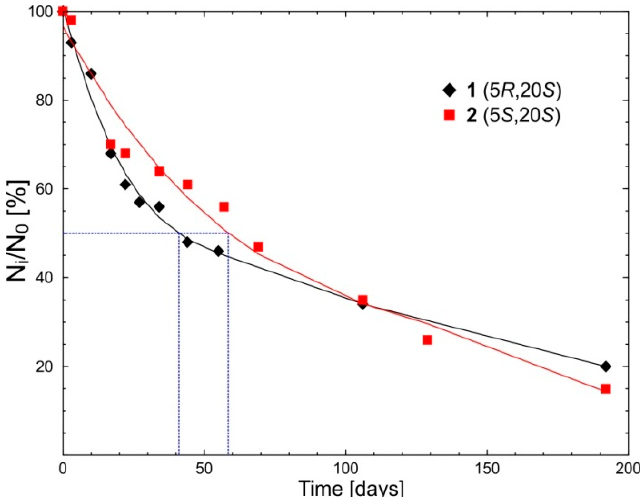
Figure 3. Kinetic graph showing the degree of degradation (Ni/N 0 ) of diastereomers 1 and 2 in D 2 O, pH 5, temp. 25 °C, over time. To determine the degree of degradation (Ni/N 0 ), the integrals of chosen Scheme 1. H NMR spectra were monitored during a given period. Ni is the average integral of selected signals in the 1 H NMR spectrum, recorded at the i-th experimental point, and N 0 is the average integral of selected signals in the 1 H NMR spectrum recorded at the beginning of the ex- periment.